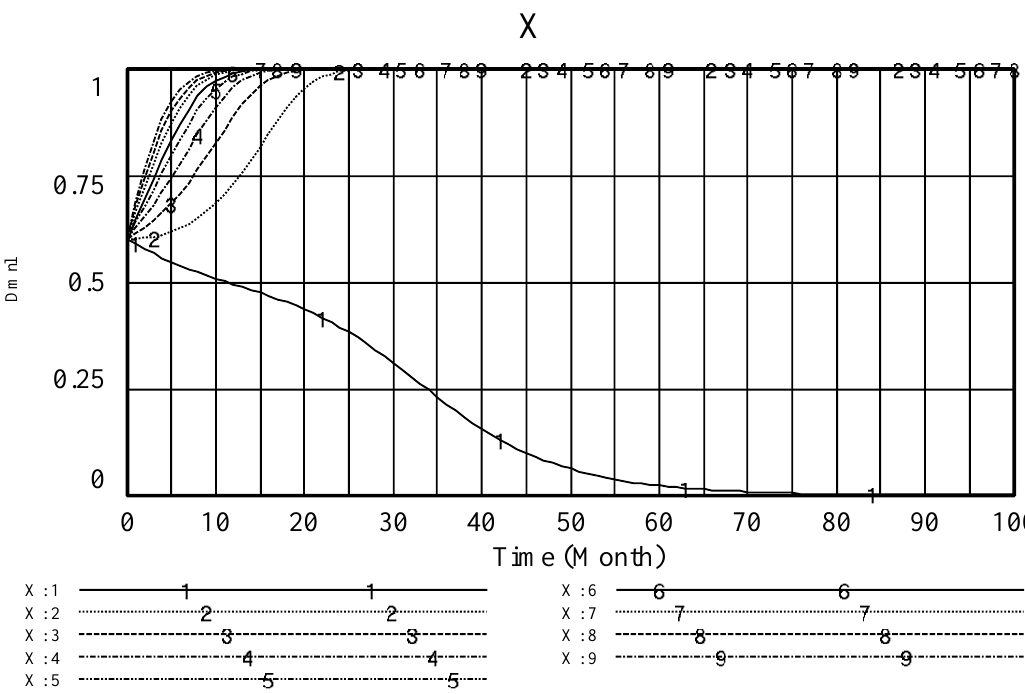
Int. J. Financial Stud. 2020 , 8 , x FOR PEER REVIEW Figure 5. Simulation result of x when initial value of x is 0.6. Figure 5. Simulation result of x when initial value of x is 0.6.